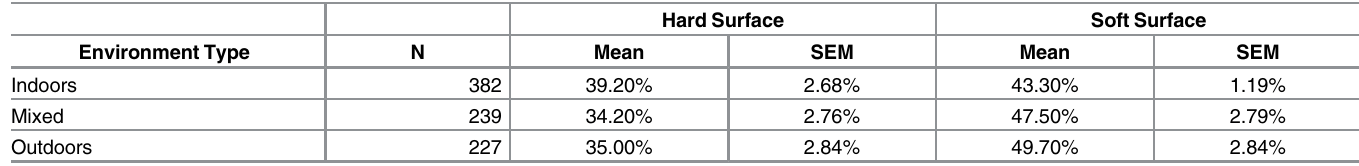
Table 10. Average percent coverage of hard surfaces (concrete and stone aggregate) and soft surfaces (grass, sand, and rubber padding) in Indoors, Mixed, and Outdoor Environments. Range for all combinations was 0 – 100% coverage.